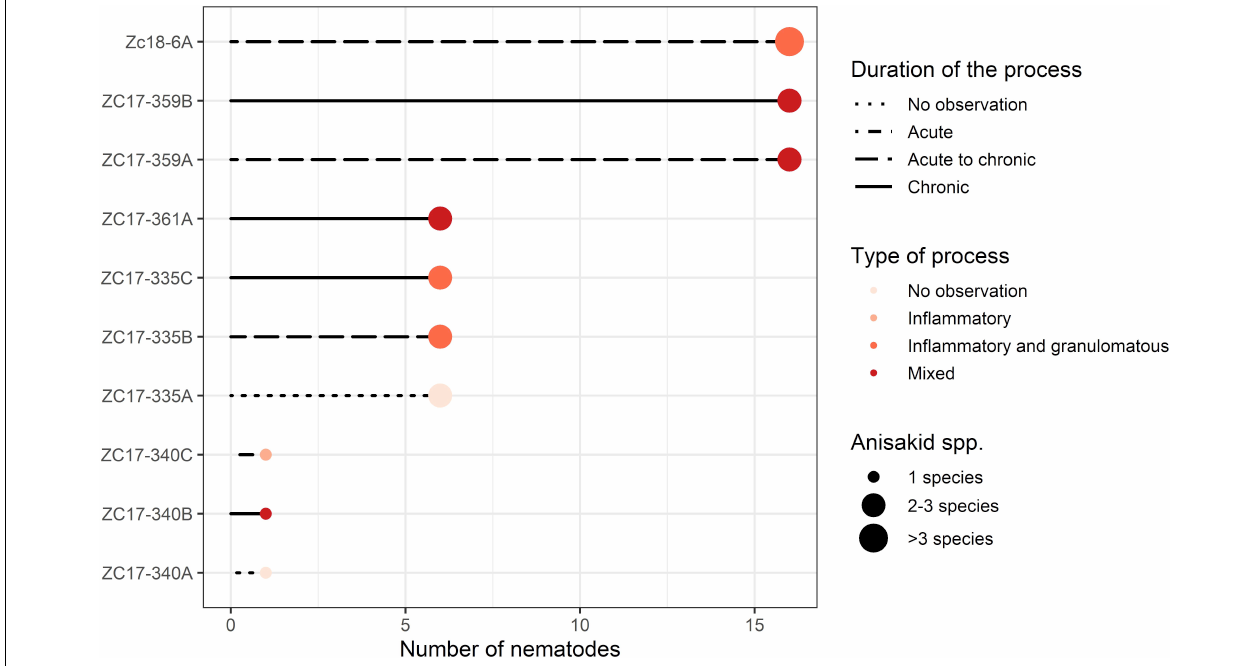
Frontiers in Marine Science |